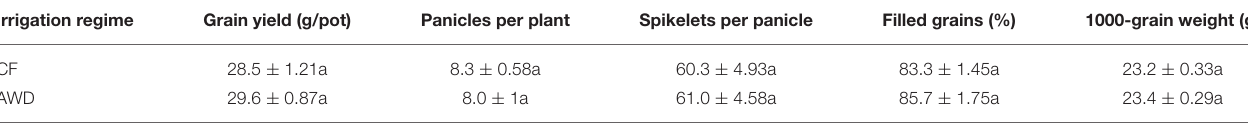
TABLE 1 | Grain yields and yield components under the two irrigation regimes. Irrigation